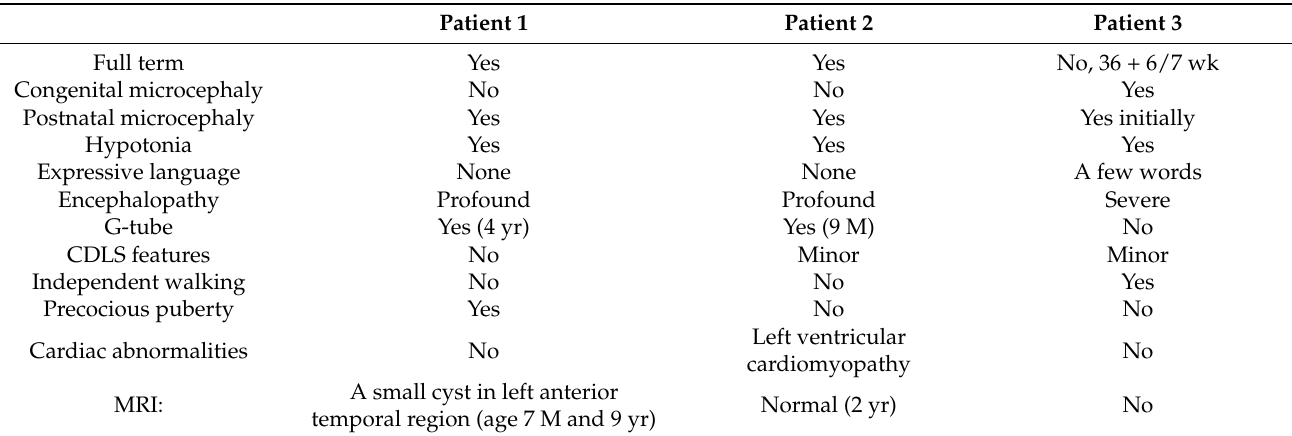
Table 1. Patients’ general